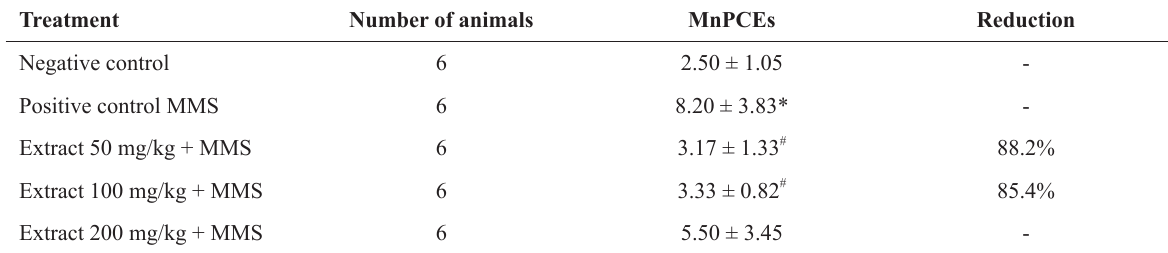
Values obtained using MN tests in bone marrow at different doses of Hibiscus acetosella after administration of